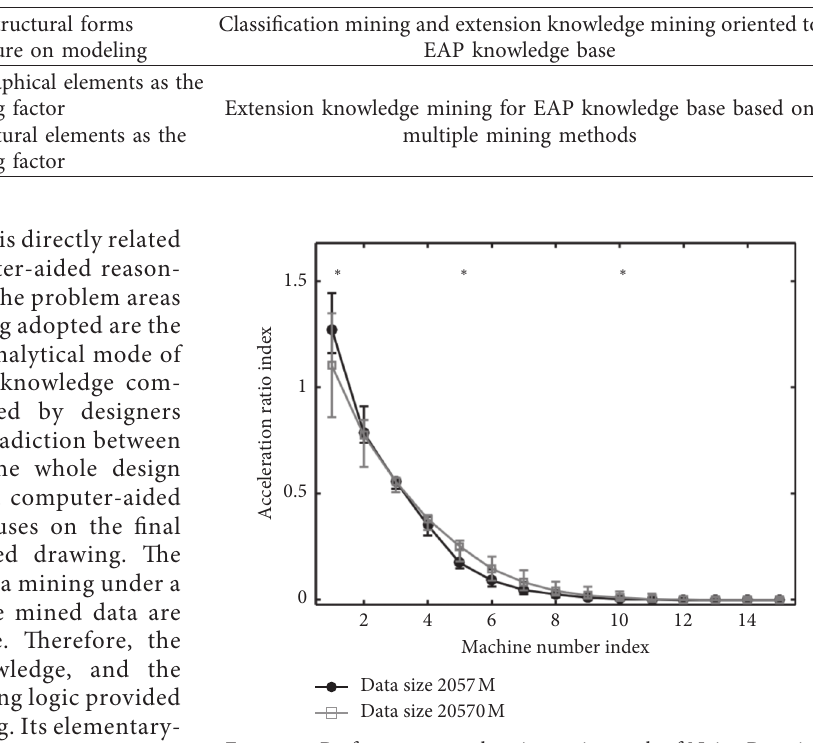
Figure 7: Performance acceleration ratio graph of Naive Bayesian